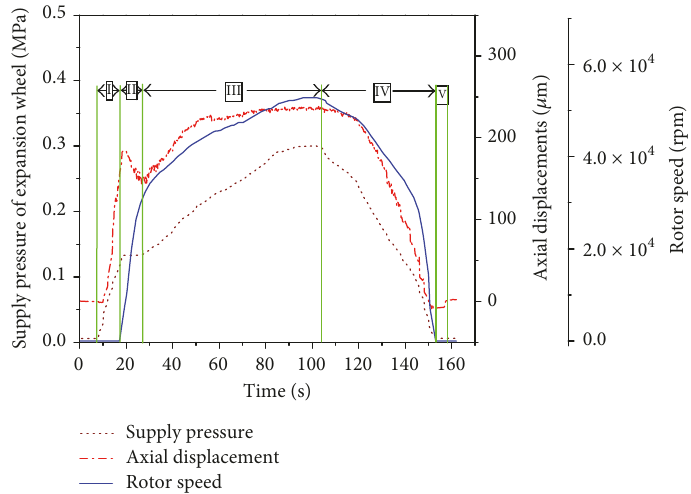
Figure 10: Axial displacement of the rotor in transient processes.